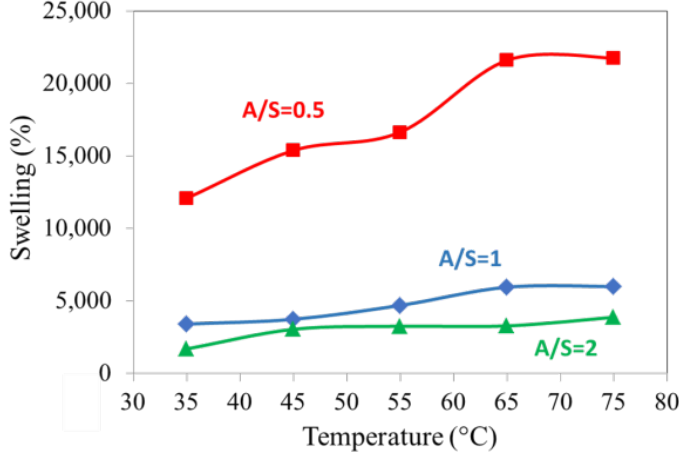
Figure 6. Temperature-responsive behavior of HPMC-g-poly(AM-co-SPA) hydrogels.